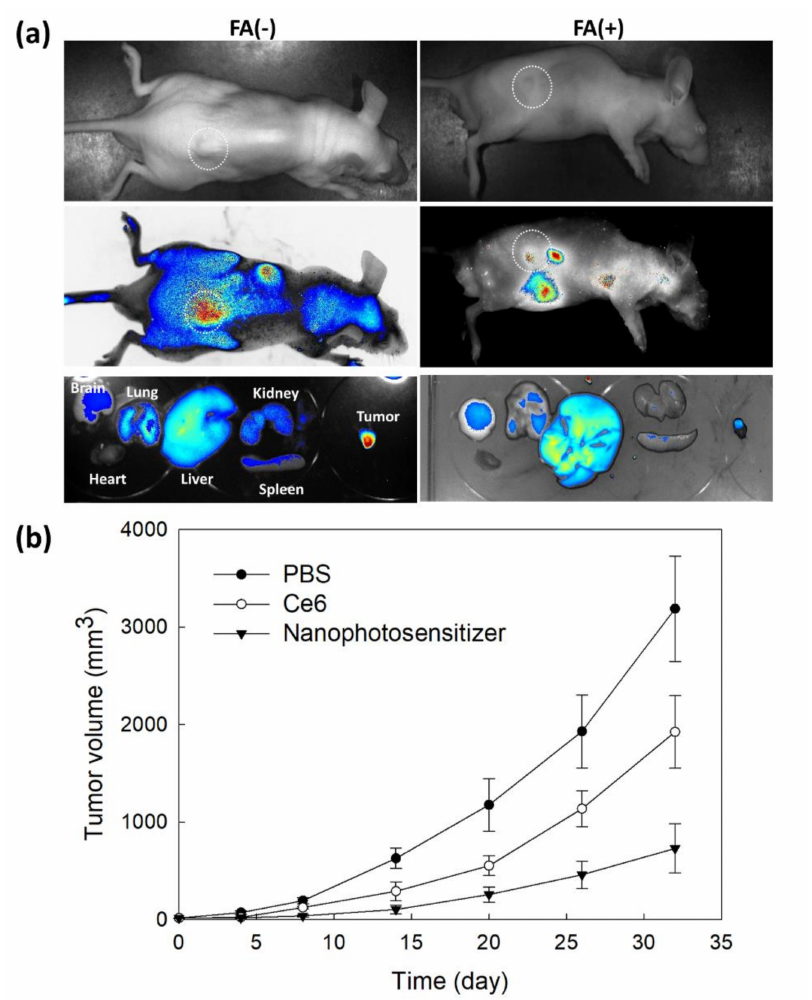
Figure 11. ( a ) In vivo animal imaging using a tumor xenograft model of HeLa cells. Fluorescence imaging of a HeLa-cell-derived tumor xenograft model of mice. Prior to the injection of the Ce6 or nanophotosensitizers, FA in PBS (pH 7.4, 0.01 M, 20 mg/kg) was i.v. injected to mice via tail veins. After that, the Ce6 or nanophotosensitizers (10 mg/kg as the Ce6 concentration) were i.v. administered. Twenty-four hours later, the mice were sacrificed and then observed for fluorescence images using Maestro II ® . ( b ) The effect of PDT on the growth of tumor masses. The Ce6 or nanophotosensitizers (10 mg/kg as a Ce6 concentration) were i.v. administered. Two days later, the mice were anesthetized for PDT treatment (2.0 J/cm 2 , 664nm). The day of the first irradiation was recorded as day 0 and, three days later, the mice were irradiated once more. Equation of tumor volume: tumor volume (mm 3 ) = (length × width 2